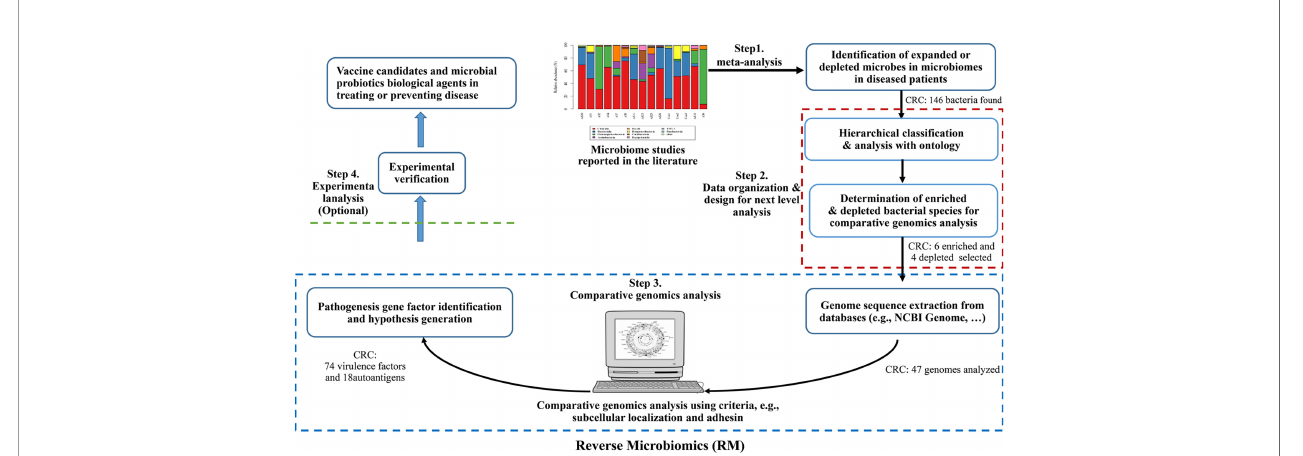
FIGURE 1 | The Reverse Microbiomics work fl ow and its application for CRC. The RM strategy includes four steps: (i) identi fi cation of differentially regulated species by literature mining and meta-analysis from published experimental studies; (ii) ontology-based hierarchical analysis of these species; (iii) comparative genomics analysis of autoantigens and virulence factors contributing to microbiome-associated diseases, and (iv) New hypotheses may also be generated and experimentally veri fi